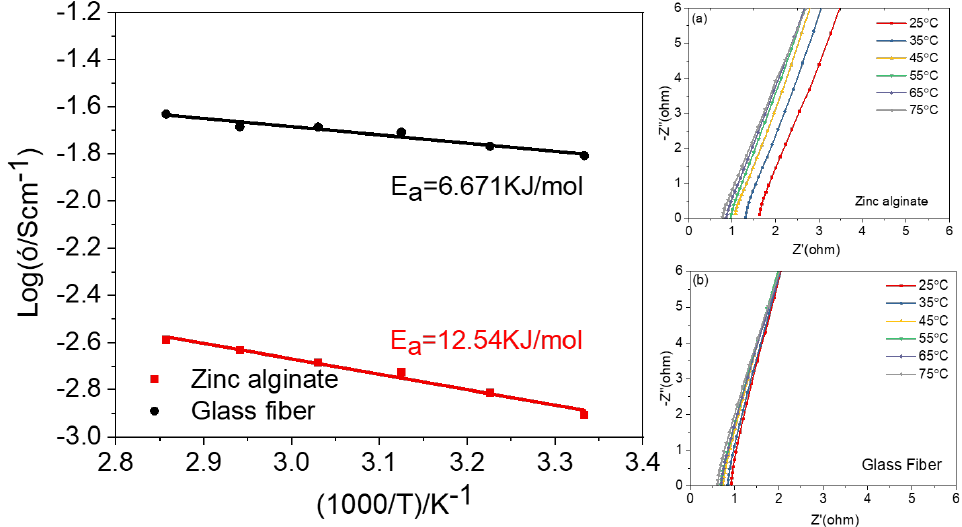
Figure 4. Arrhenius plot of the ZA-based HGPE and the glass-fiber separator saturated with ZnSO 4 electrolyte. Insets are the impedance plots of the ( a ) ZA-based HGPE and ( b ) wet glass-fiber separator at different temperatures.